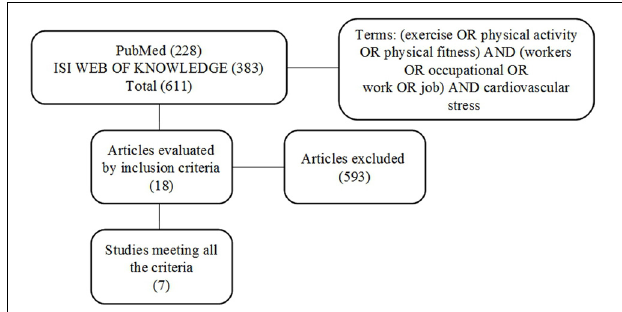
FIGURE 1 | Overview of search